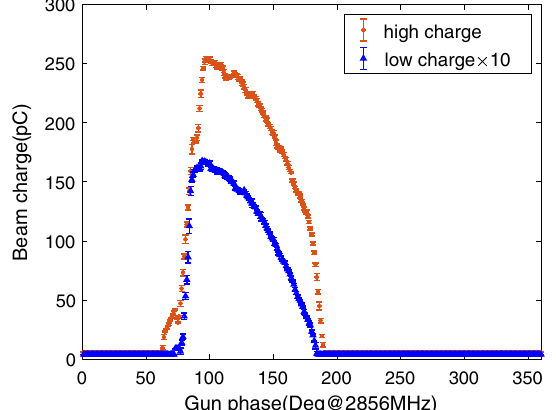
FIG. 5. Bunch charge change in gun rf phase scan. The rf phase is read from the LLRF system.